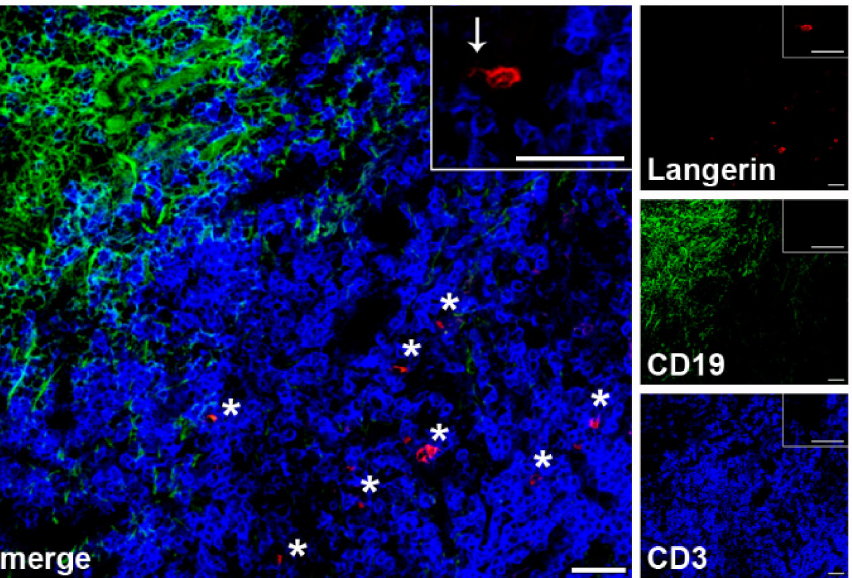
Figure 1. LCs localization within SLN areas of melanoma patients. Three-color immunofluorescence labelling was performed on frozen SLN sections ( n = 4 negative and n = 1 positive SLNs from n = 5 patients) with the indicated Abs and fluorescences (anti-Langerin, red; CD19, green; CD3, blue) in order to localize LCs within specific SLN areas. A representative negative SLN is shown. Original magnification × 200 and × 400 in the inset; scale bars = 20 µ m and 40 µ m, respectively. SLN LCs are found in the T cells rich areas, as indicated by asterisks; a typical SLN LC, with typical thin and long dendrites, is shown in the inset, as indicated by an